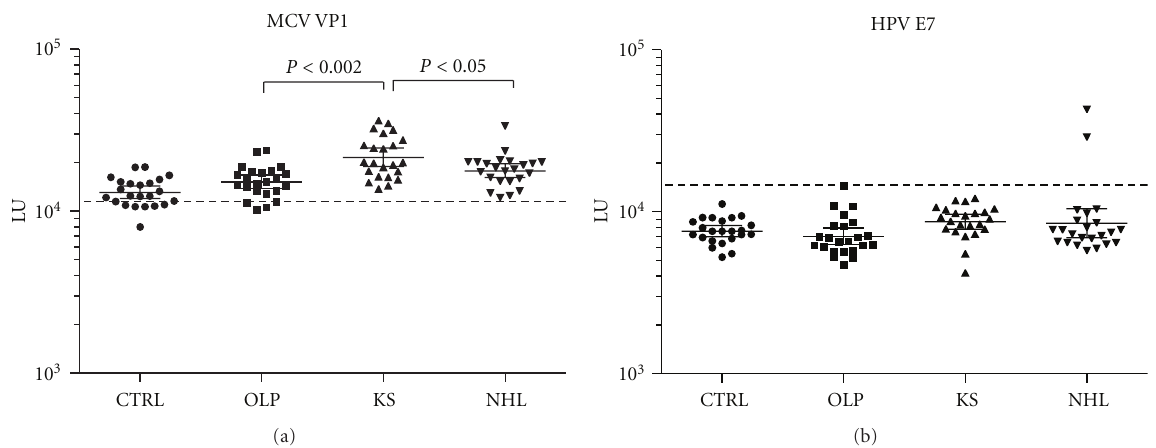
Figure 5: Profiling anti-HPV and anti-MCV antibodies. The antibody levels and 95% CI are shown for (a) MCV VP1 and (b) E7 HPV-16 in the 23 control blood donors, 23 OLP, 23 KS, and 23 NHL subjects. The antibody levels for each individual are plotted on the Y -axis using a scale. The dashed line represents the cut-o ff level for determining seropositivity. P values for the di ff erent groups were calculated using log 10 the Mann Whitney U